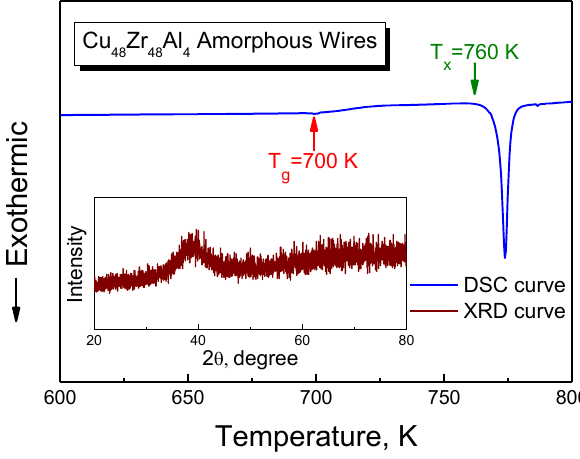
Figure 2. The differential scanning calorimeter (DSC) curve of Cu 48 Zr 48 Al 4 amorphous microwires with the glass transition temperature and crystallization onset temperature. The inset plot is an X-ray diffraction (XRD) pattern of wires.